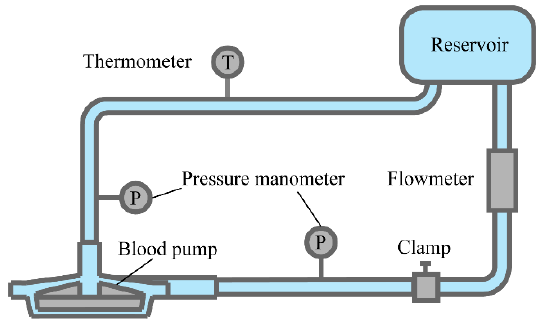
Figure 4. Schematic diagram of pump performance test rig.